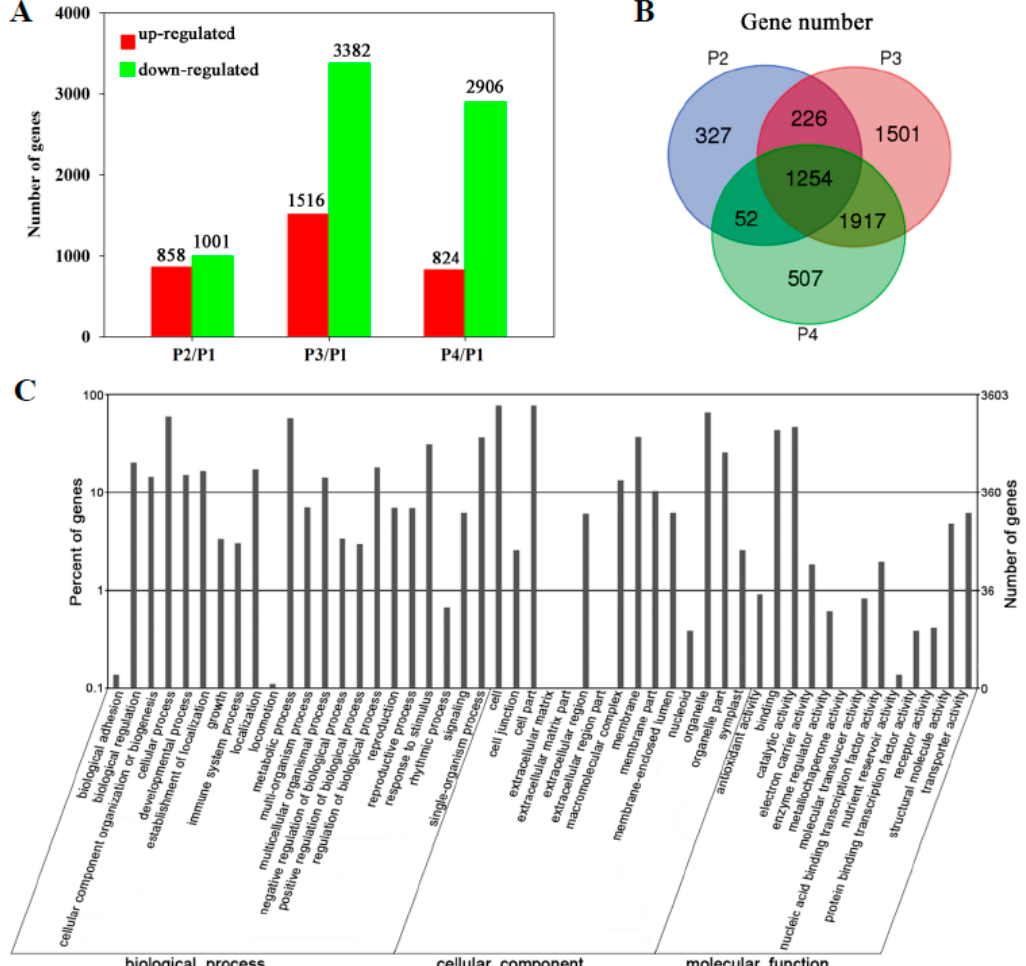
Figure 2. Transcriptomic profiling of banana peel during fruit ripening. ( A ) Numbers of differentially expressed genes in the peel at different stages of ripening. The numbers of up-regulated genes and down-regulated genes at different stages of ripening are indicated with red and green color, respectively; ( B ) Venn diagram illustrating the corresponding numbers of differentially expressed genes in different stages of ripening; ( C ) gene ontology term assignments based on significant plant species hits against the National Center for Biotechnology Information (NCBI) non- redundant (NR) database, according to the biological process, molecular function, and cellular component.